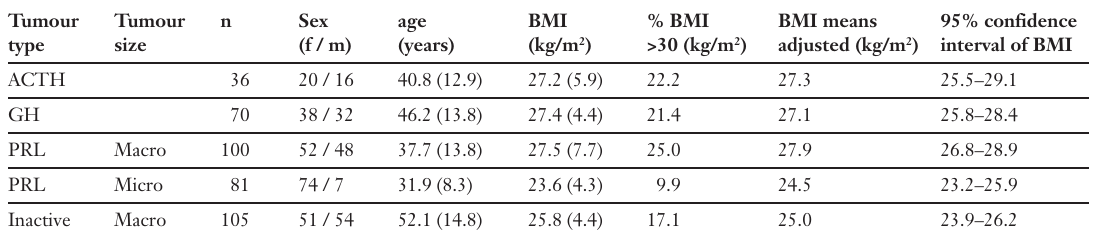
Effect of treatment of macroprolactin- oma in obese pa- tients on tumour control and body mass